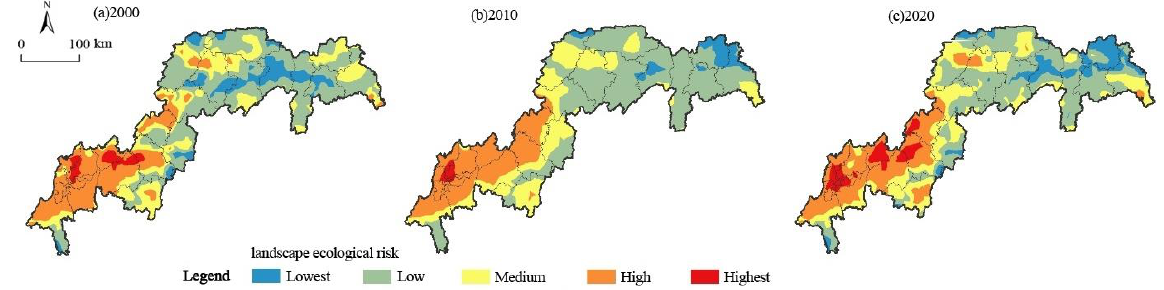
Figure 4. Spatial distribution map of LER levels in the TGRR from 2000 to